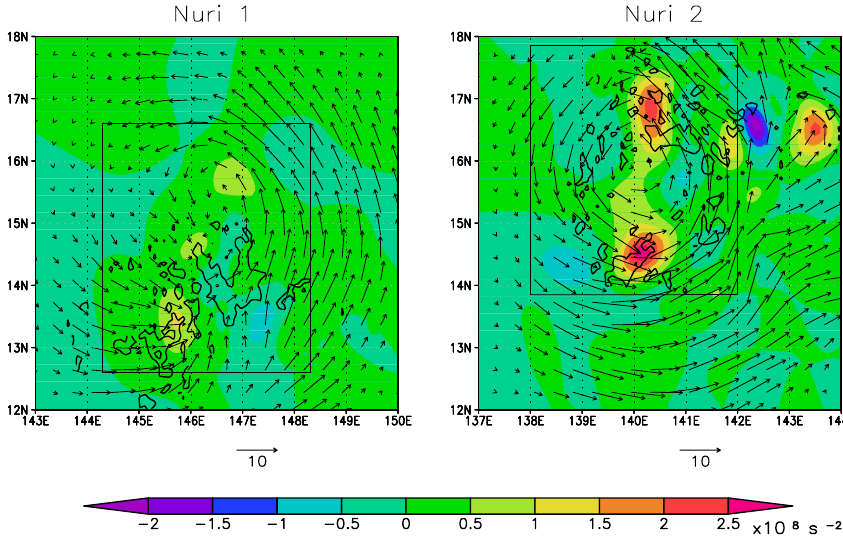
Figure 10. Two-panel plot of low-level stretching tendency (shaded) for Nuri 1 (left) and Nuri 2 (right). The maximum stretching tendency between the surface and 1km is displayed. The arrows are wind vectors in the co-moving frame at 1.5km altitude and the thick black lines are the 25dBZ contour from the ELDORA data at 5km. The black box is the four-degree length box centered on the 1.5km sweet spot position and is for reference only. The abscissa is longitude and the ordinate is latitude.